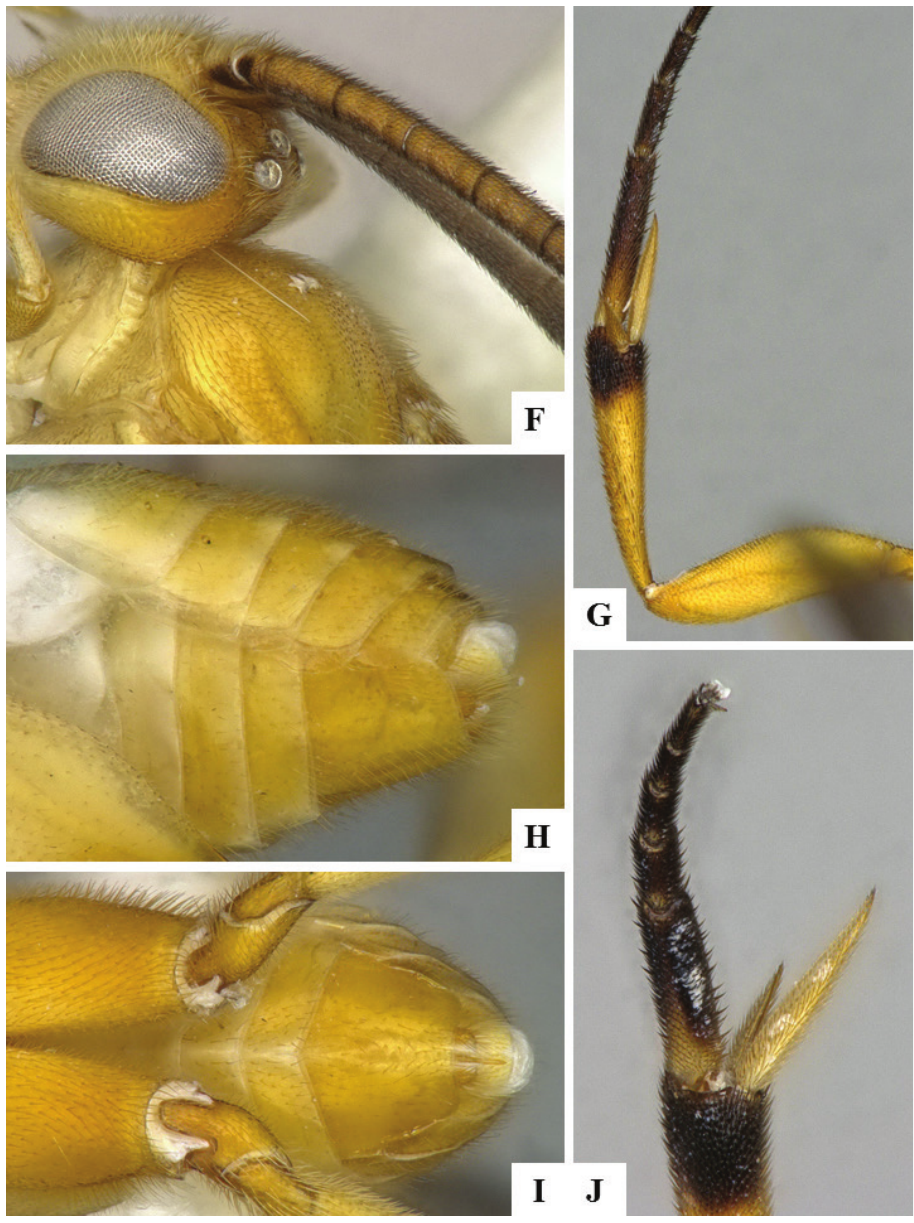
Figure 23. Jimwhitfieldius jamesi female holotype. F Antennal flagellomeres 1 to 4 G Hind leg H Hypopy- gium and ovipositor, lateral I Hypopygium and ovipositor, ventral J Inner and outer spines of metatibia. land and Vietnam (75–100 m), whereas all known specimens of J. sydneyae have been collected at higher altitudes (273–924 m). DNA barcodes of the two species also have more than 2% of base pair